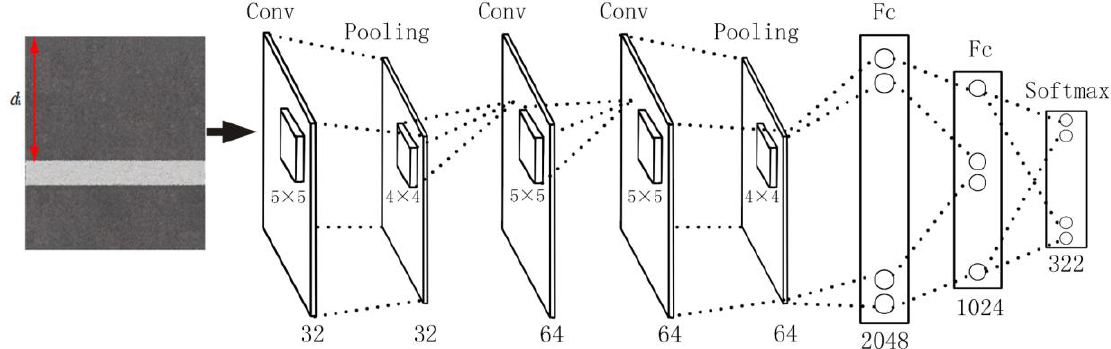
Figure 6. The LatDisLanes network architecture.